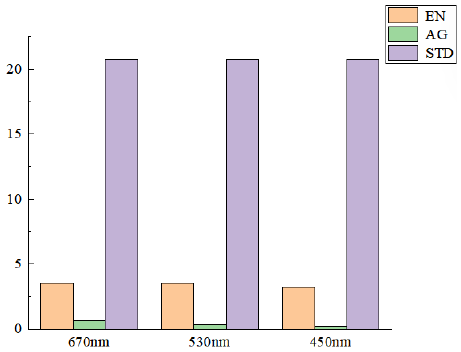
Figure 10. Evaluation indexes of multi-band target polarization images in sea fog environment.